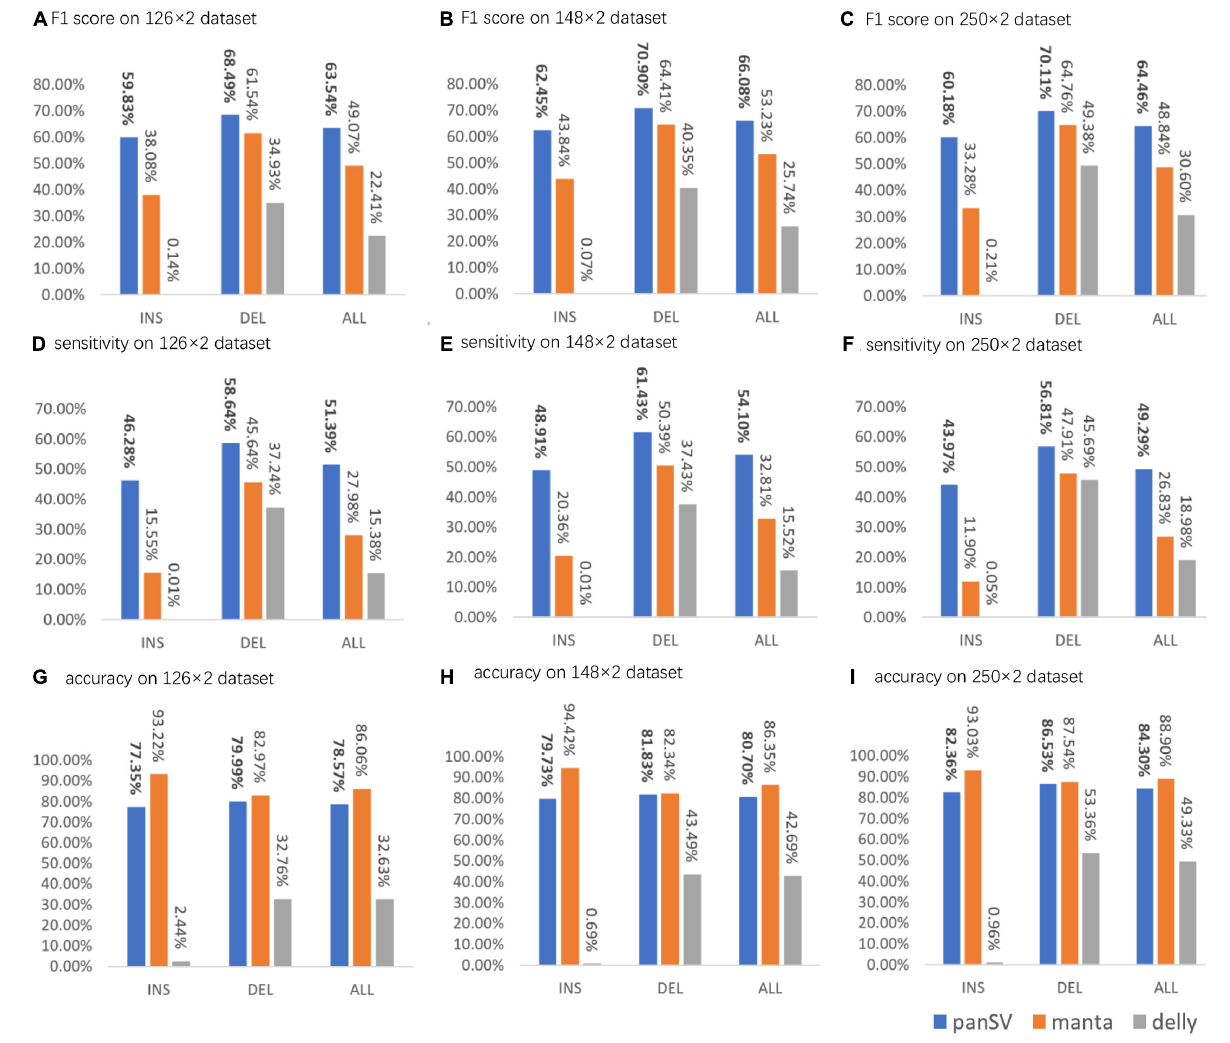
FIGURE 3 | The sensitivity, precision and F1 score of PanSVR, manta and delly on three NGS datasets. (A,D,G) F1 score, sensitivity and accuracy of SV calling results of PanSVR, manta and delly applied on Illumina 126 × 2 dataset; (B,E,H) The SV calling results of those tools on Illumina 148 × 2 dataset; (C,F,I) The SV calling results of those tools on Illumina 250 × 2